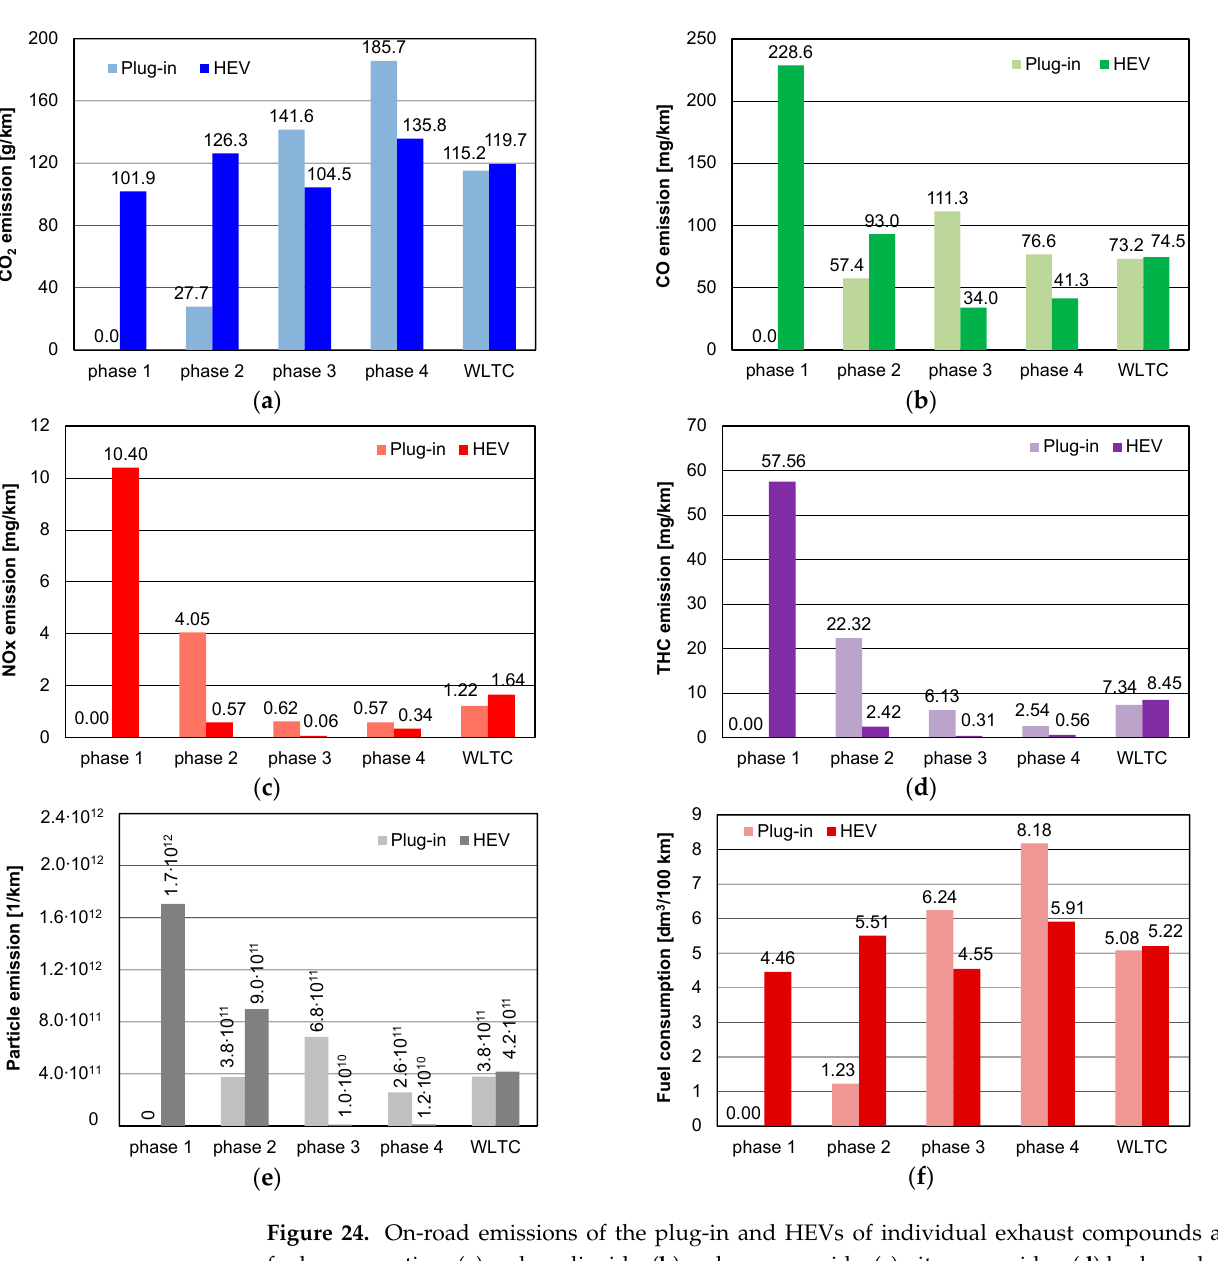
power of 60 kW, the average exhaust emission of CO was of 0.25 ± 0.08 g/km. These values average exhaust emission of NO x was 0.009 ± 0.005 g/km. These values were up to 8.3-fold were up to 3.4-fold greater compared to the present analysed cases of the plug-in and HEV. higher than those of the present analysed cases of the plug-in and HEV.